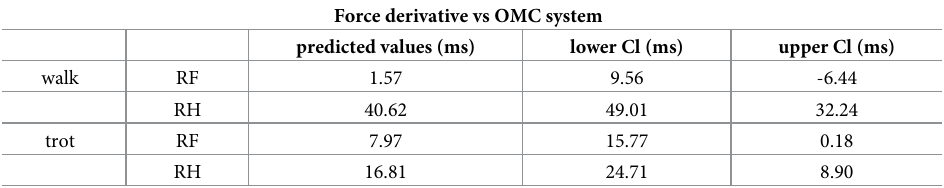
Table 2. Linear mixed model results for the reference methods, OMC system and force